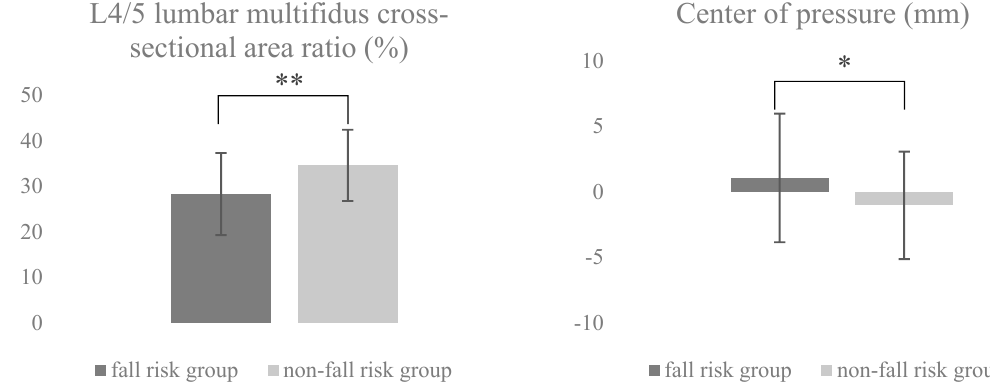
Figure 1. L4/5 lumbar multifidus cross-sectional area ratio for magnetic resonance imaging data and the center of pressure displacement for trials on the balance board. * p < 0.05, ** p < 0.005.